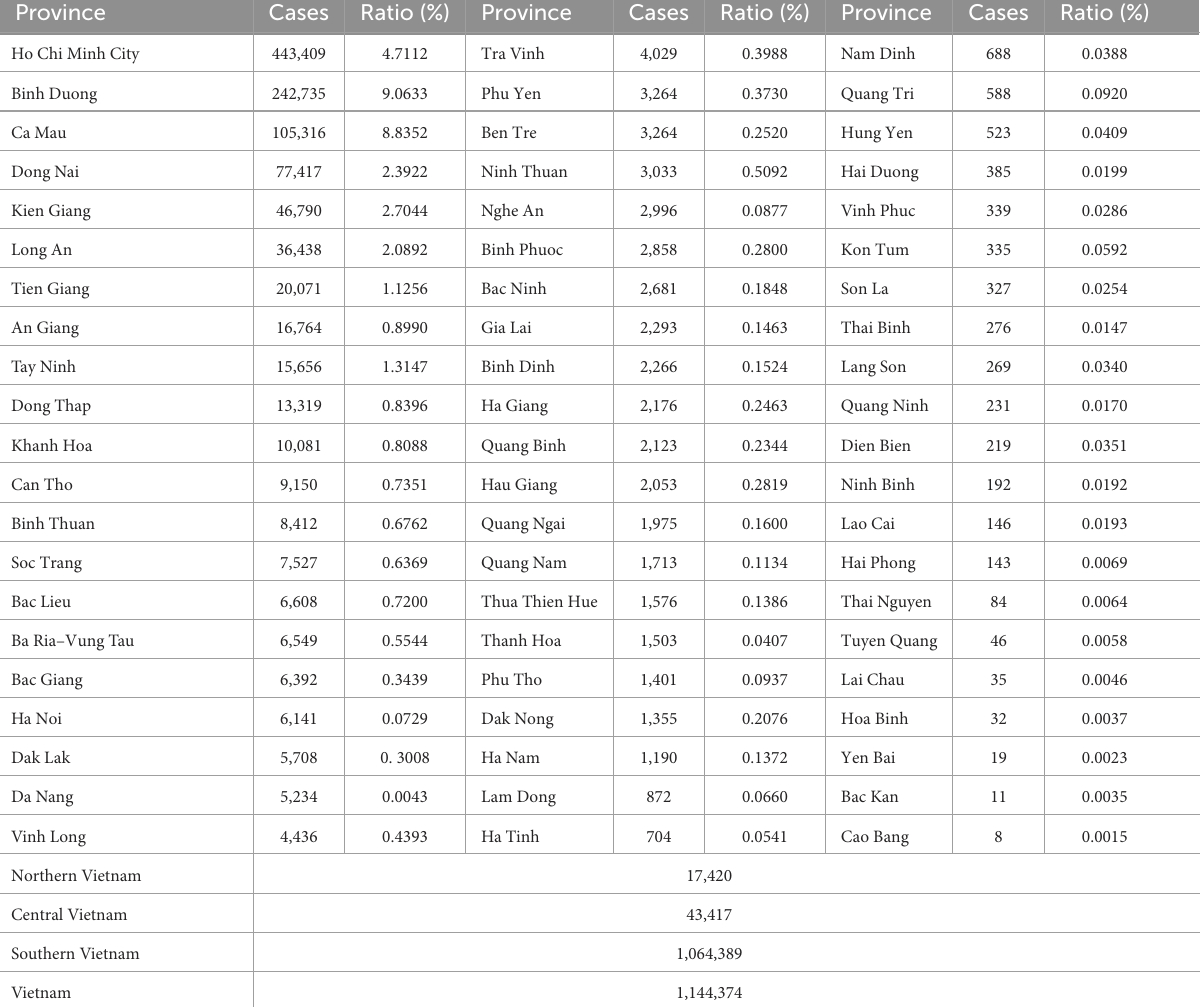
TABLE 1 Total number of COVID-19 cases the ratio of infected cases in the population from 27/4/2021 to 13/11/2021. Province Cases Ratio (%) Province Cases Ratio (%) Province Cases Ratio